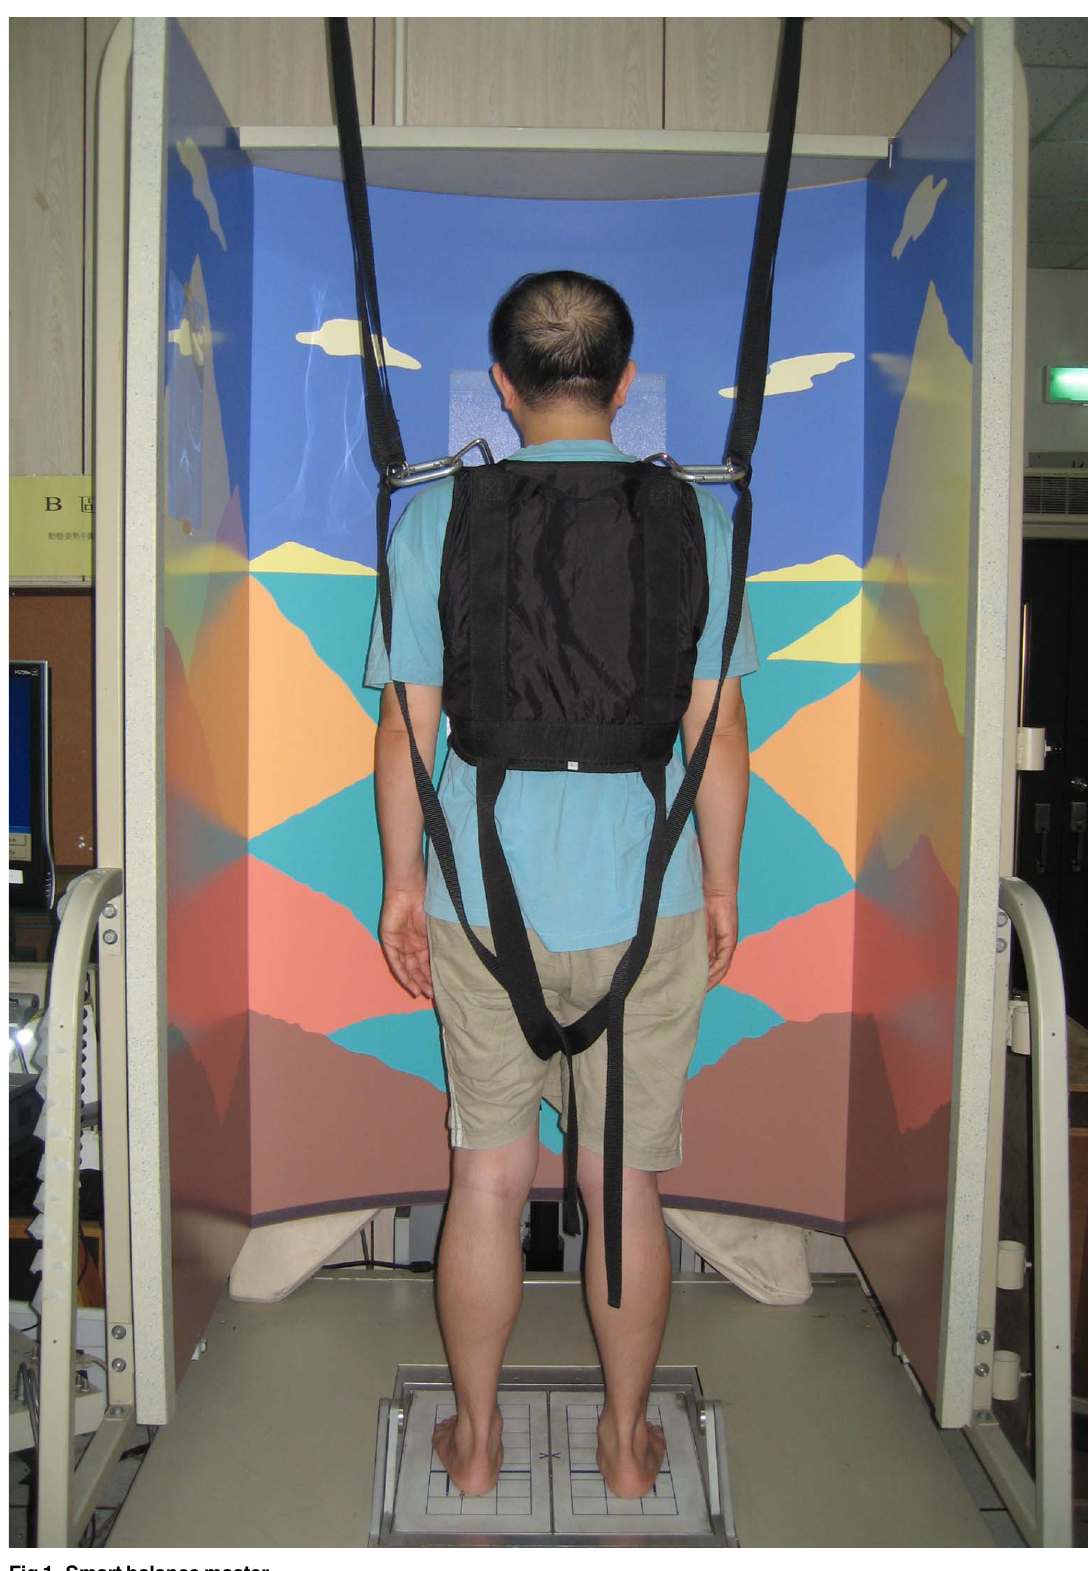
Fig 1. Smart balance